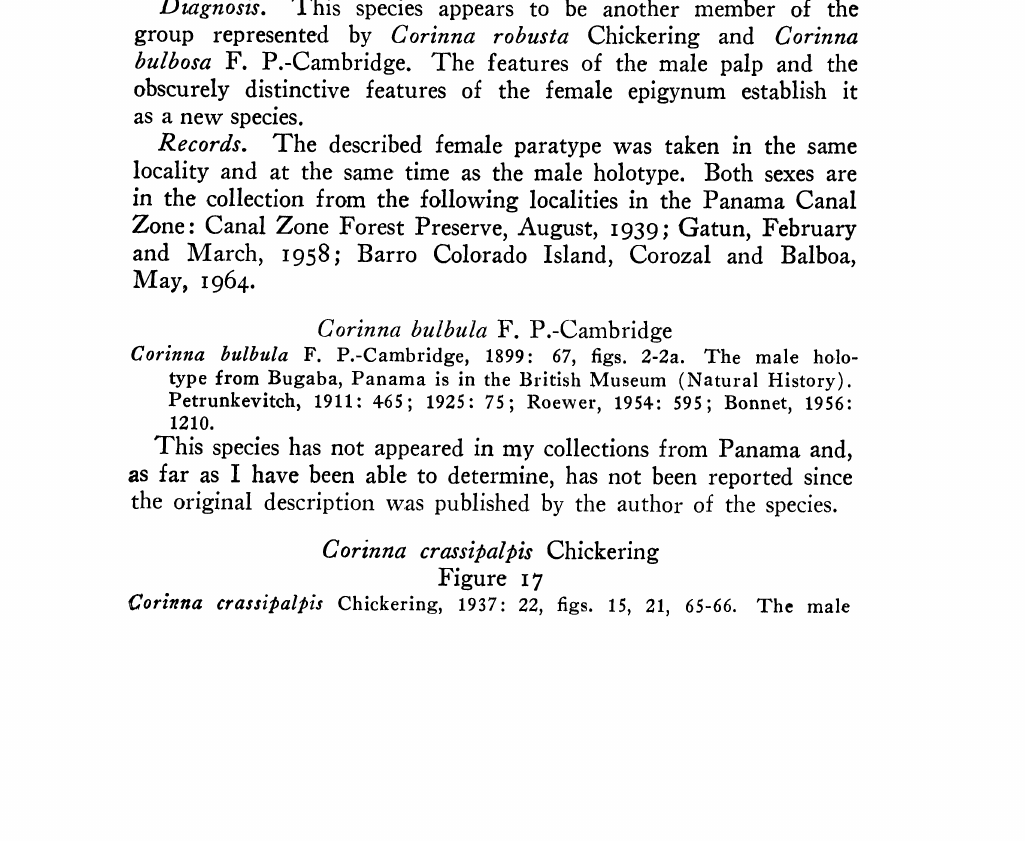
Figure 17 C’orinna crassi#al#is Chiekering, 1937: 22, figs. 15, 21, 65-66. The